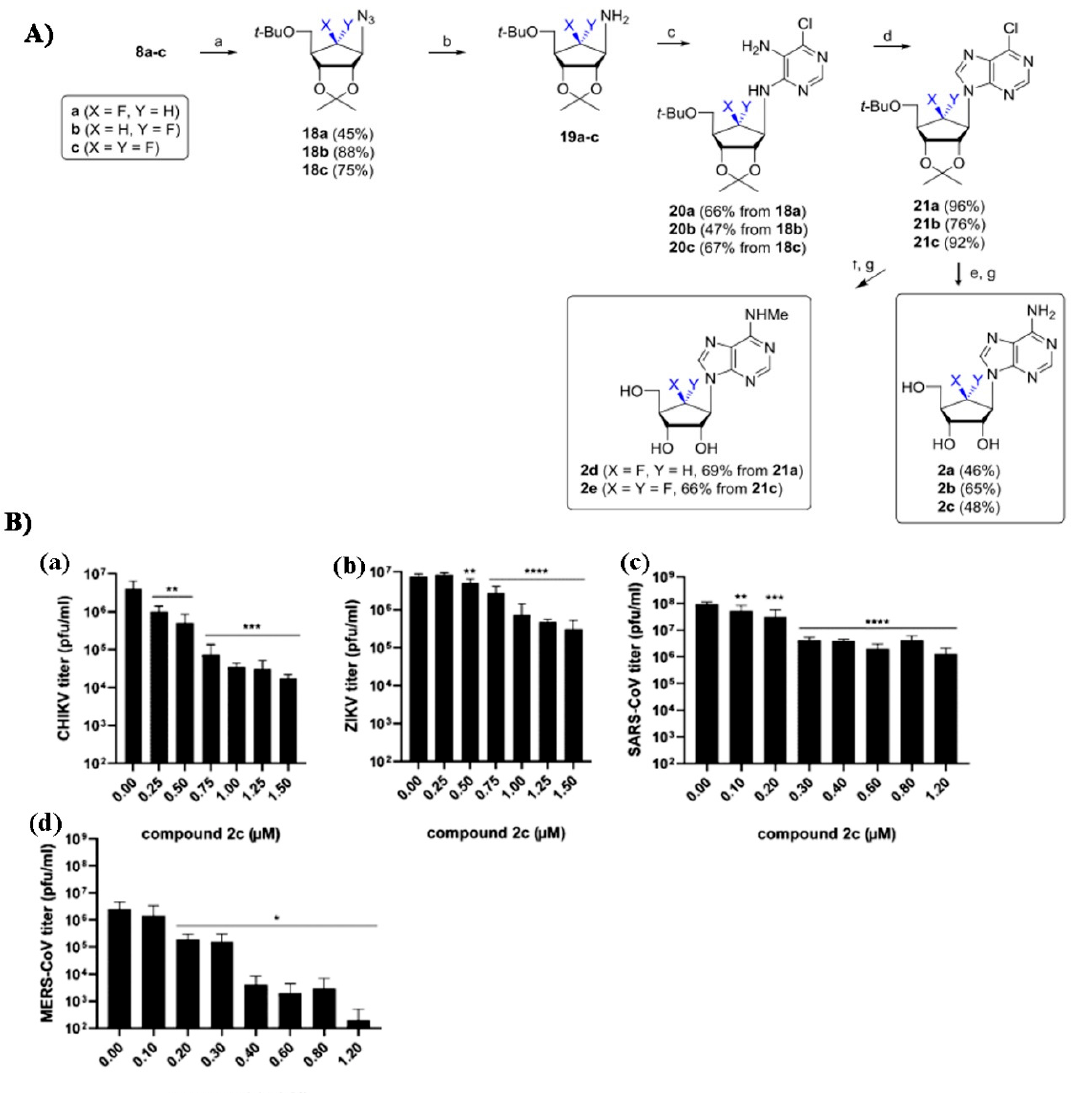
Figure 16. ( A )—Synthesis of some analogs as was demonstrated by Jeong et al.; ( B )—Effect of 2c on the infectious progeny of CHIKV ( a ), ZIKV ( b ), SARS-CoV ( c ), and MERS-CoV ( d ). The largest effect was observed on MERS-CoV. Republished with permission Yoon JS, Kim G, Jarhad DB, Kim HR, Shin YS, Qu S, et al. Design, Synthesis, and Anti-RNA Virus Activity of 6 ′ -Fluorinated-Aristeromycin Analogues. J Med Chem 2019;62:6346–62. Copyright (2019) American Chemical Society [149].